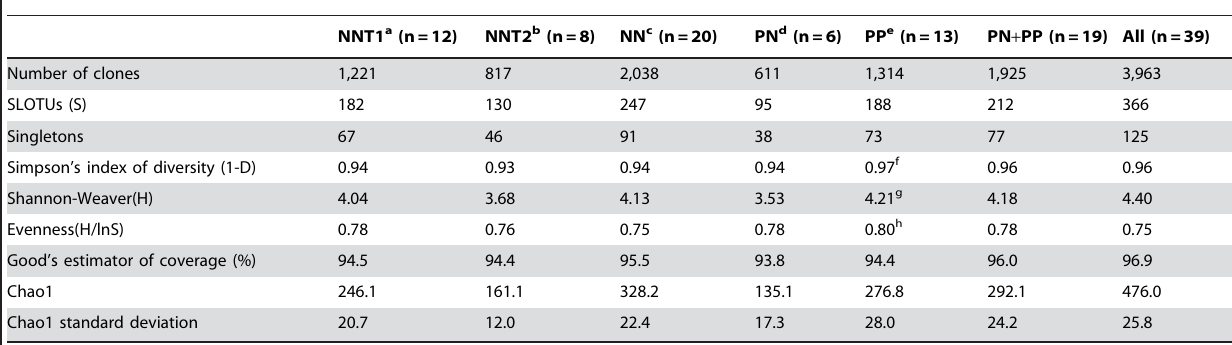
Table 1. Sequence diversity and library coverage